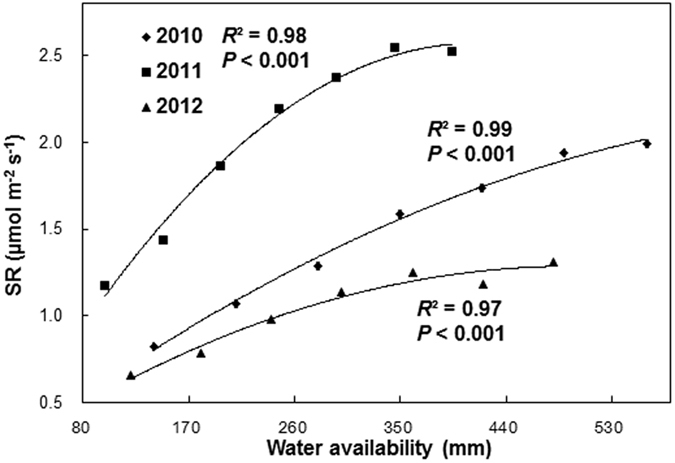
Nonlinear response patterns of soil respiration (SR) along the precipitation gradient in 2010 (y = −3E-06x2 + 0.005x + 0.13), 2011 (y = −1E-05x2 + 0.012x + 0.06), and 2012 (y = −5E-06x2 + 0.005x + 0.16).Each data point represents the annual mean of each treatment.